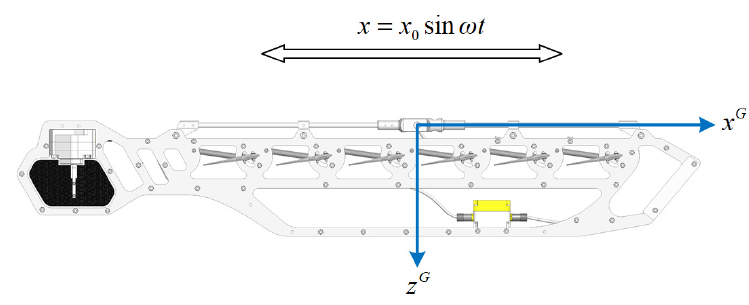
Figure 8. The schematic diagram of the pure surge test. The pure surge test is simulated in FLUENT based on the dynamic mesh technique, with restrictions on other degrees of freedom, and the pure surge motion is defined as: u = x , w = 0, q = 0 where x , u and u are, respectively, displacement, velocity and acceleration in surge direction, ω is oscillation angular frequency, and x 0 is surge oscillation amplitude. Figure 9 shows the pressure contours of the submerged glider in pure surge simulation when pitching angle of the hydrofoils is 15 degrees.